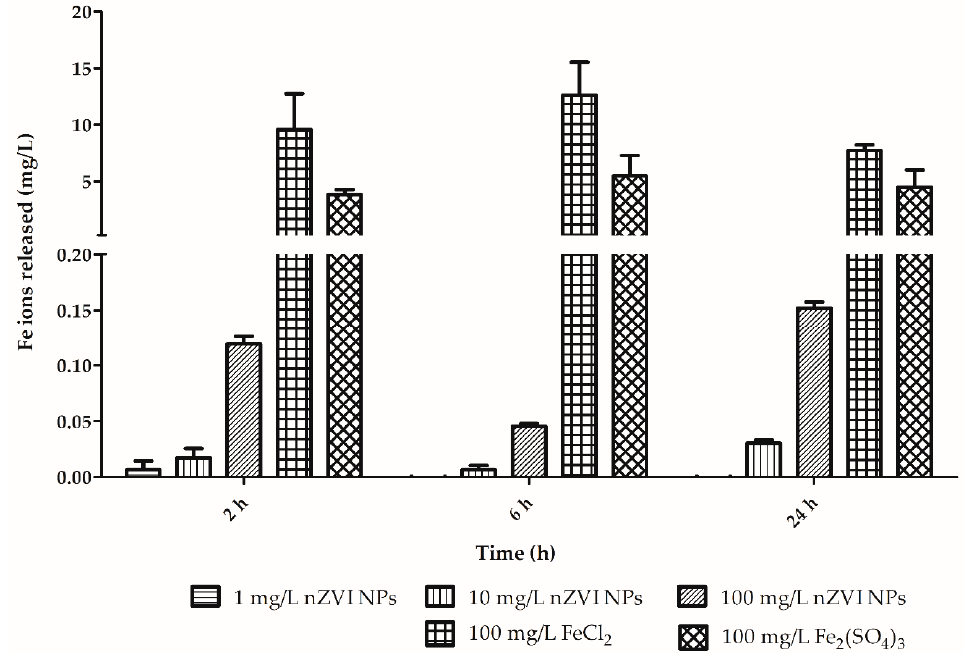
Figure 3. Soluble iron released from different sources during exposure in RPMI 1640 medium.